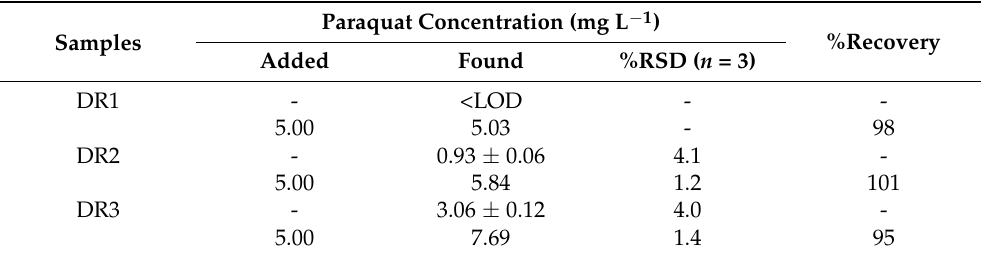
Table 4. Investigation of paraquat concentration and recovery study with online extraction for daikon radish samples.